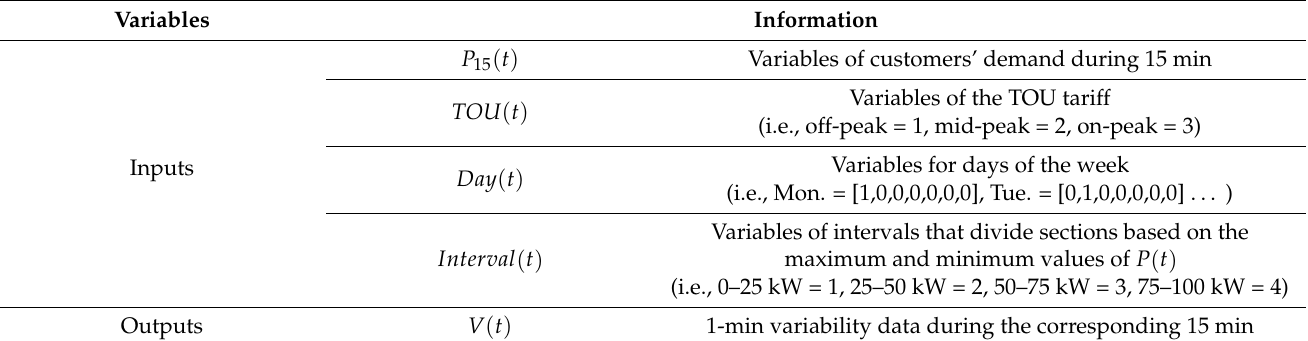
Table 3. Configuration of training